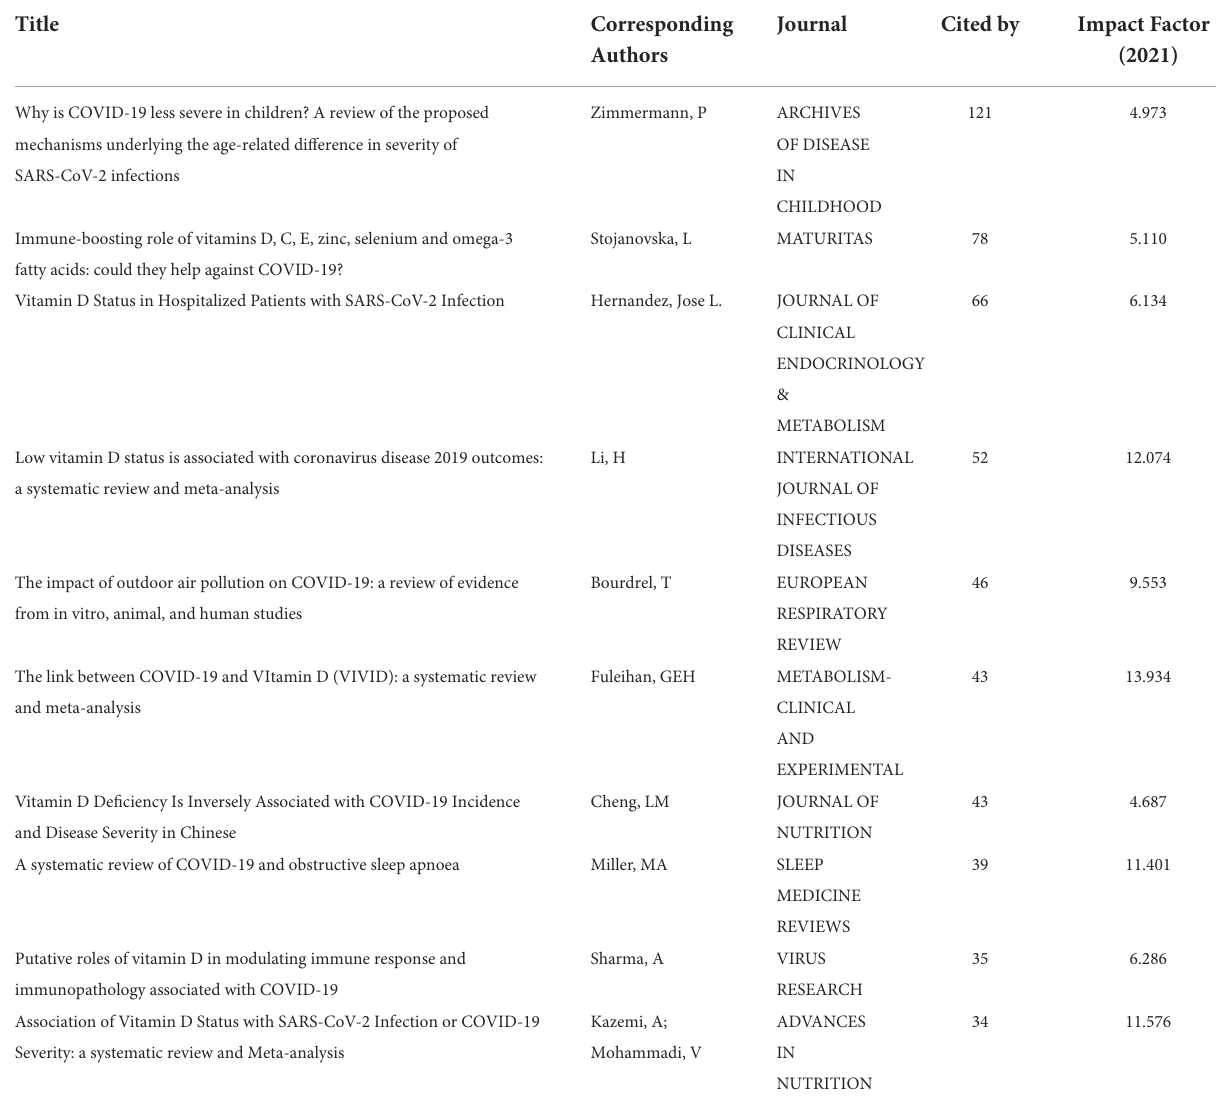
TABLE 5 Top cited articles in 2021 related to vitamin D and